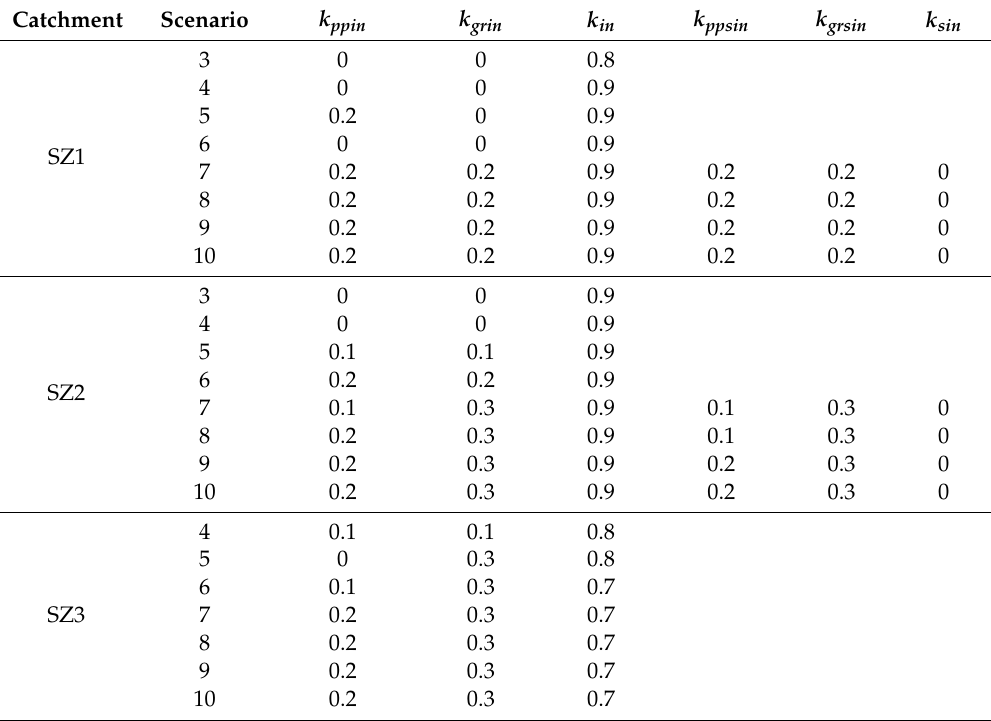
Table 12. Optimal combination of k ppin , k grin , k in , k ppsin , k grsin , and k sin for new developments.